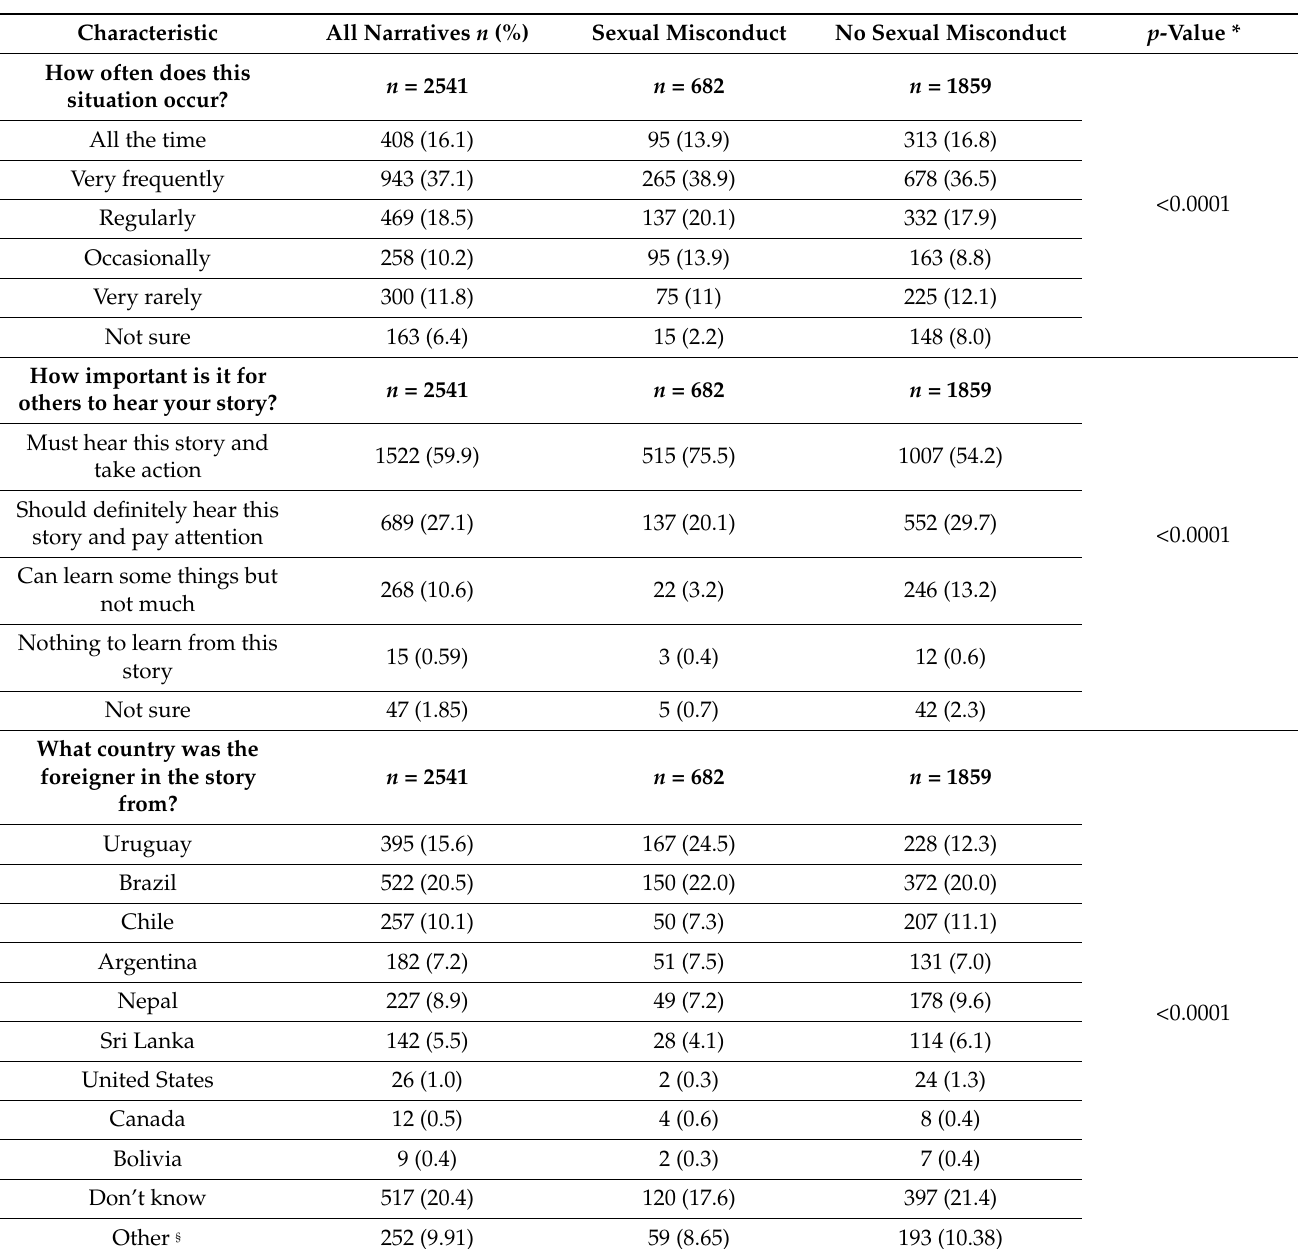
Table 4. Association between geographical location and narratives addressing sexual misconduct. Exposure